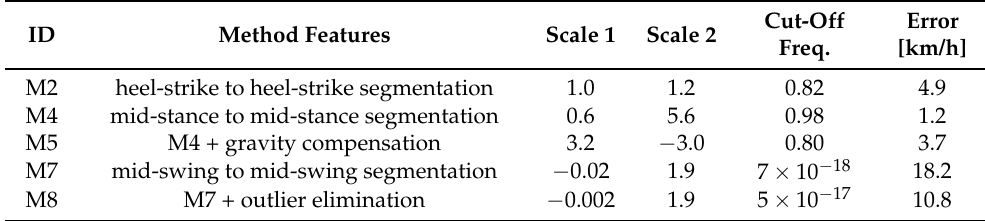
Table 5. Tuning parameters and performance of the conventional methods from [24] using their